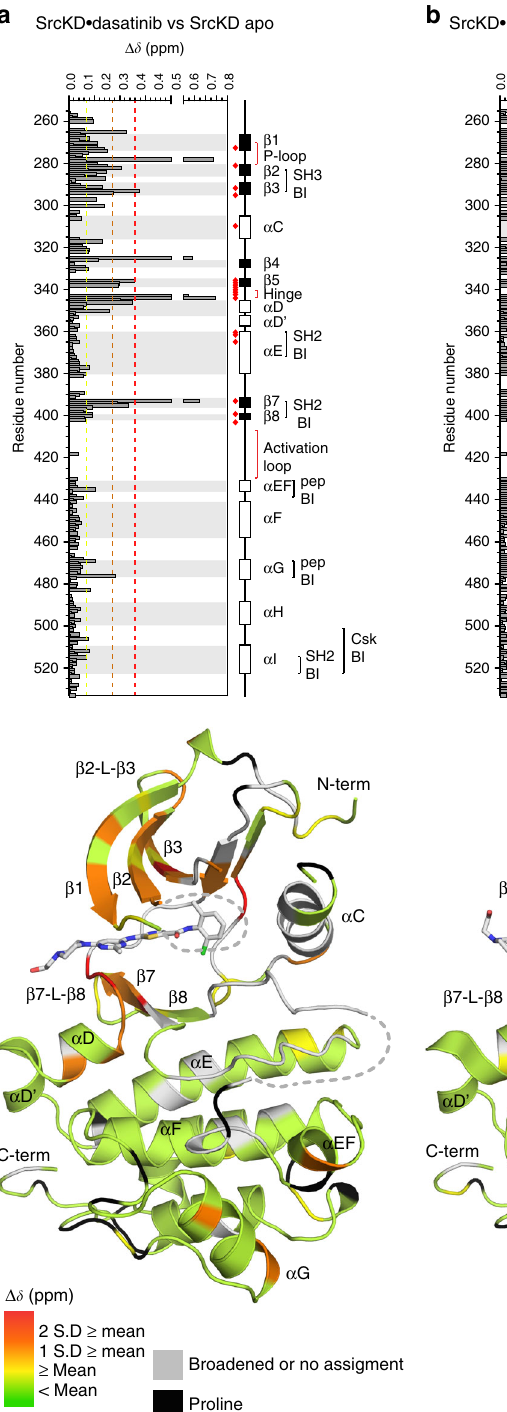
Fig. 3 Binding of conformation-selective ligands to apo SrcKD induces CSP near the ATP-binding site and at select C-lobe residues. CSPs induced in SrcKD upon binding: a dasatinib, b DAS-DFGO2, c DAS-CHO2, were analyzed by histograms and by CSP mapping to their structures (PDB-entry 3G5D, 4YBJ, 4YBK) 30,31 . Large CSPs occur predominantly around the inhibitors binding site in the active site cleft. Some residues within the C-lobe exhibit moderate CSPs suggesting that long-range allosteric effects are propagated. In the upper histogram panels, pep denotes peptide and BI denotes binding interface. Secondary structure elements β 6 and β 9 are absent in the structures here and in subsequent fi gures when the activation loop is disordered. The yellow, orange, and red histogram dashed lines here and in subsequent CSP fi gures indicate the magnitiude of the CSPs corresponding to the mean, 1 and 2 S.D. equal to or greater than the mean